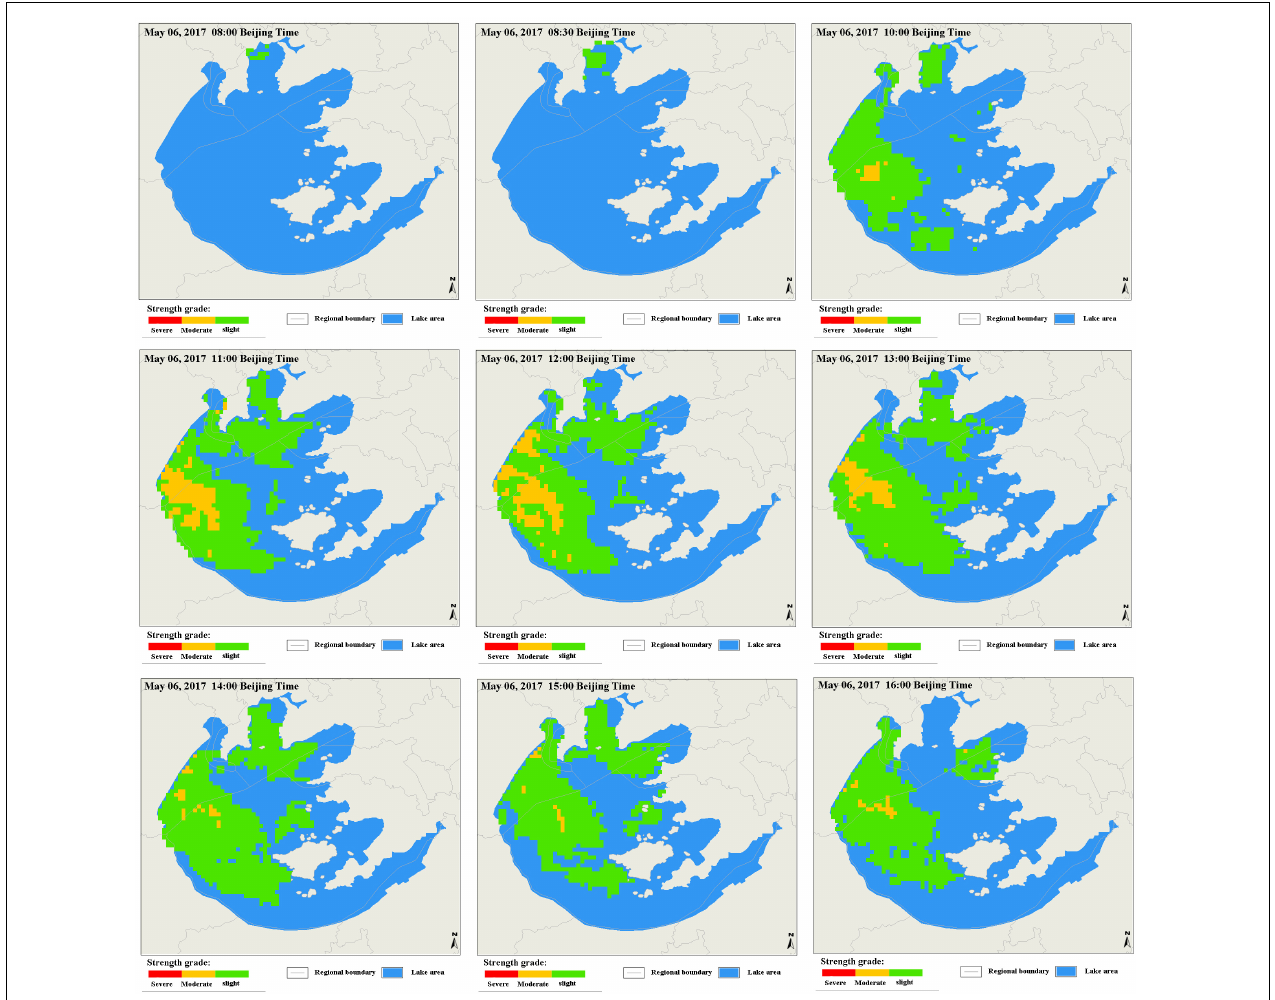
FIGURE 10 | Floating algae detection using FY-4A/AGRI data for Taihu Lake, China, on 6 May 2017 (08:00–16:00 Beijing time).